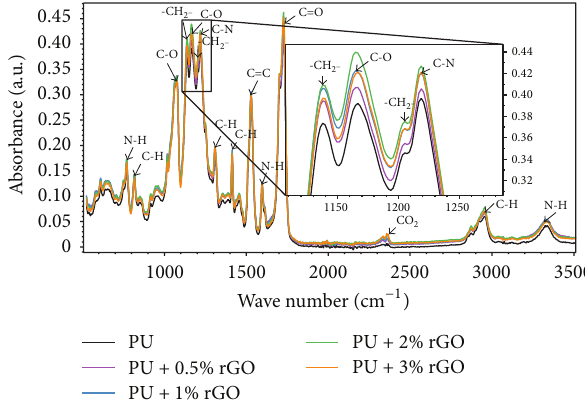
Figure 6: FTIR spectra of PU